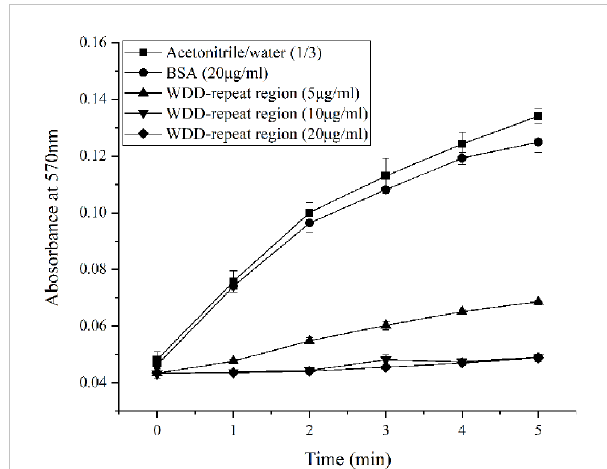
FIGURE 7 Inhibitory activity of WDD-repeat region polypeptide on the crystallization rate of calcium carbonate., Acetonitrile/water (1/3) mixture;, BSA (20 m g/mL);, WDD-repeat region (5 m g/mL);, WDD- repeat region (10 m g/mL);, WDD-repeat region (20 m